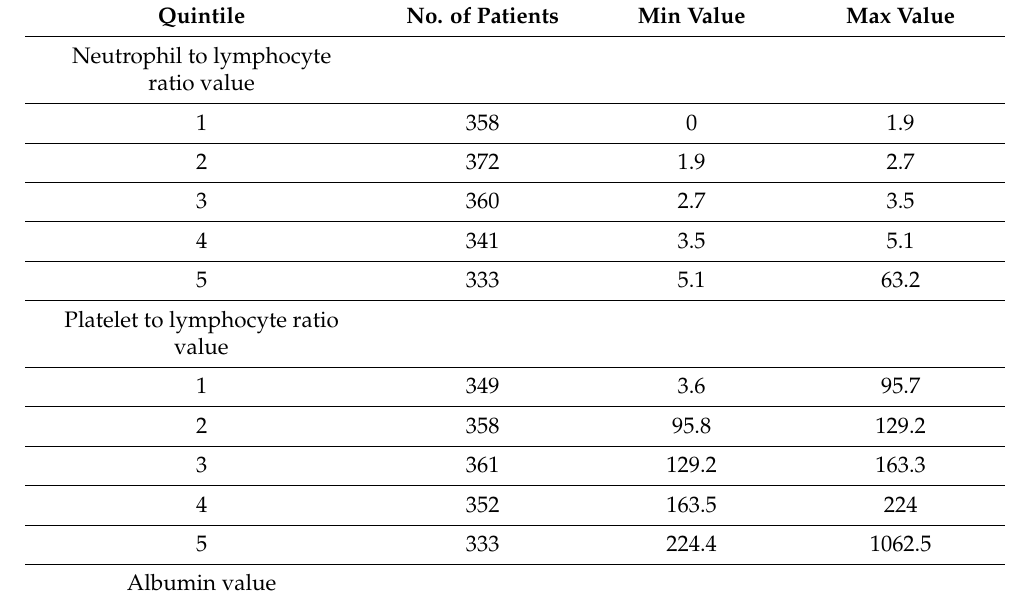
Table A3. Categorization of the independent